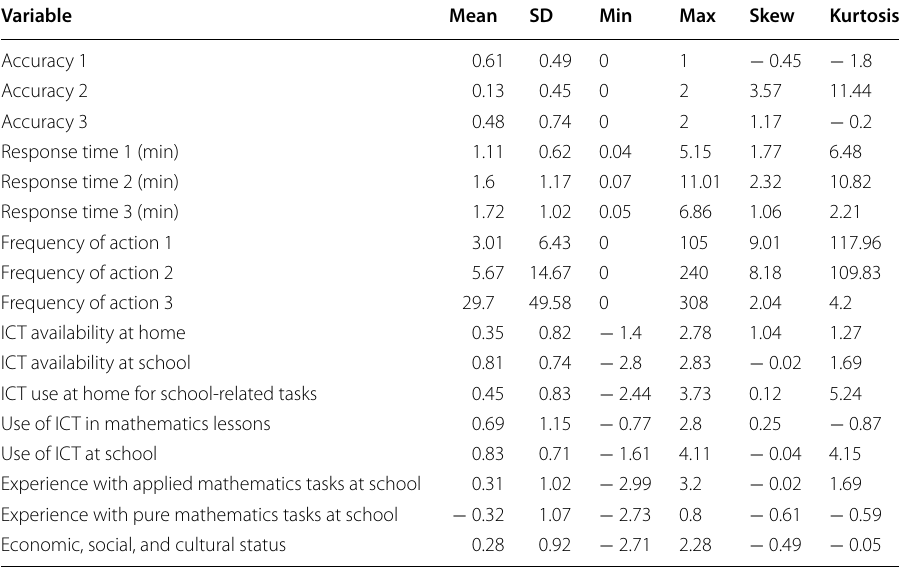
Table 11 Descriptive analysis of the indicators in their original metrics for Denmark Variable